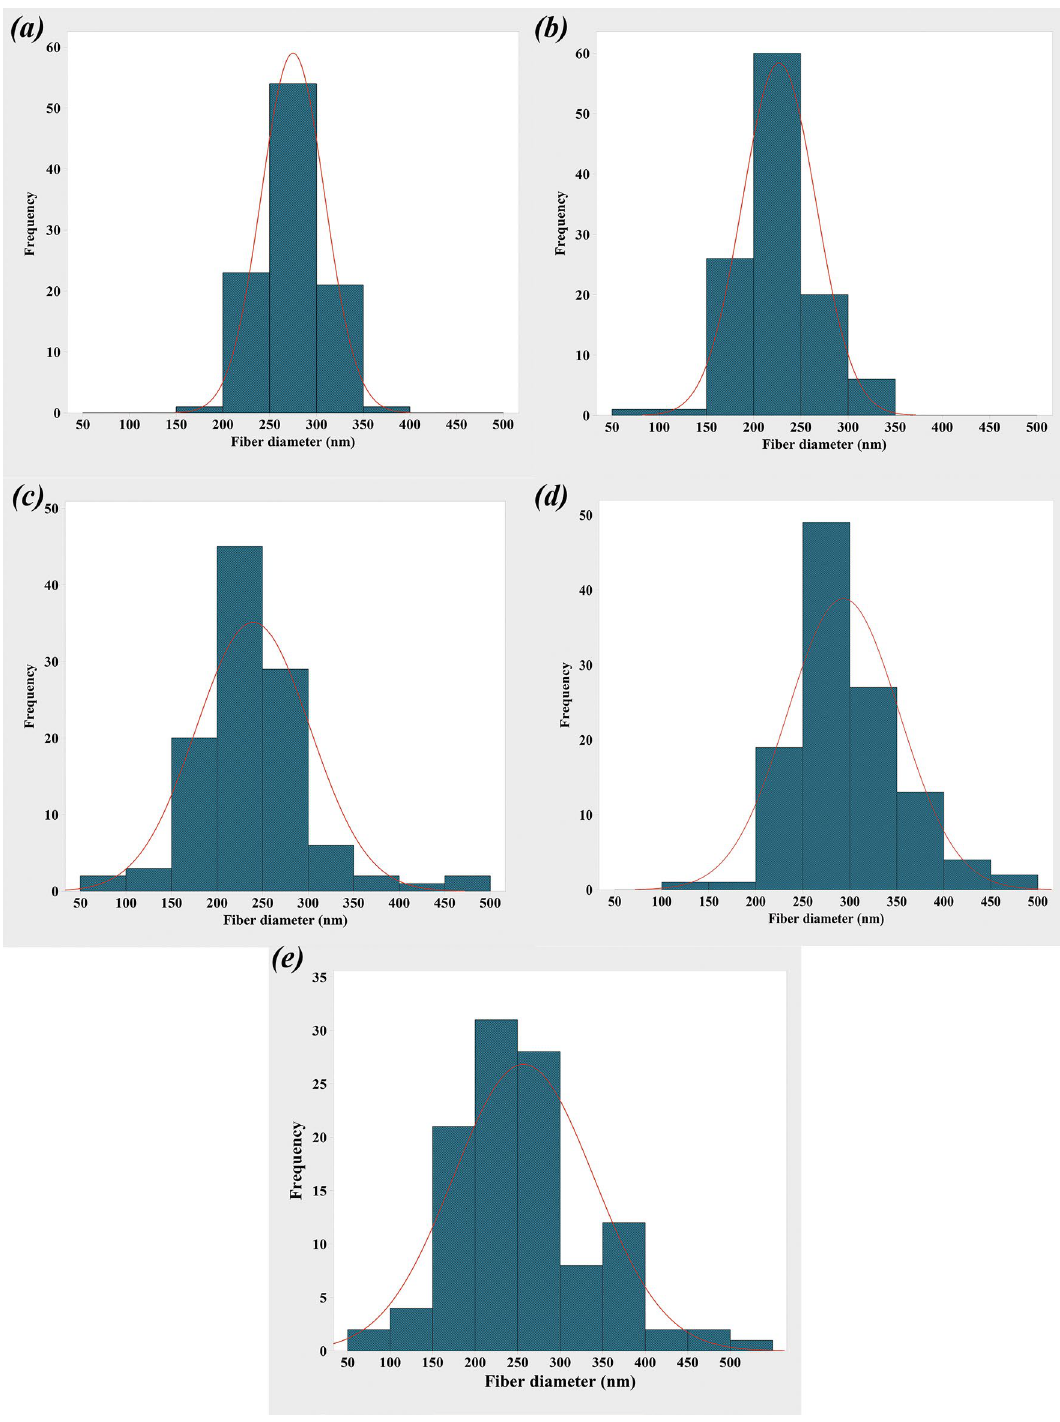
Figure 6. The histogram of the fiber diameter distribution and the curve of normal-log distribution of the electrospun scaffolds: ( a ) PCL, ( b ) PCL-10HAMP, ( c ) PCL-20HAMP, ( d ) PCL-30HAMP, and ( e ) reported that the combination of PCL and collagen reduces the fiber diameter 23,31 . With increasing the HAMP percentage in PCL-20HAMP and PCL-30HAMP, the viscosity and the average diameter of the fibers increased. The sharp increase in the mean fiber diameter in the PCL-30HAMP sample is due to a simultaneous decrease in the electrical conductivity in addition to an increase in viscosity (Figs. 3 and 4). In PCL-40HAMP, increasing the viscosity increased the average diameter of the fibers. The membranes containing HAMP displayed significantly increased fiber diameter range from 50 to 500 nm similar to fibers of Bruch’s membrane 35 . This increase in fiber diameter range is probably due to an increase in